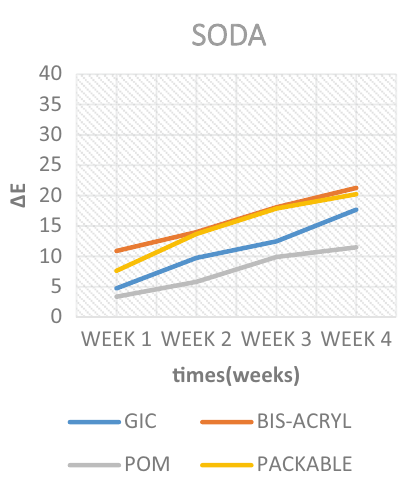
Fig. 7 Colour change over time of test materials in distilled water.